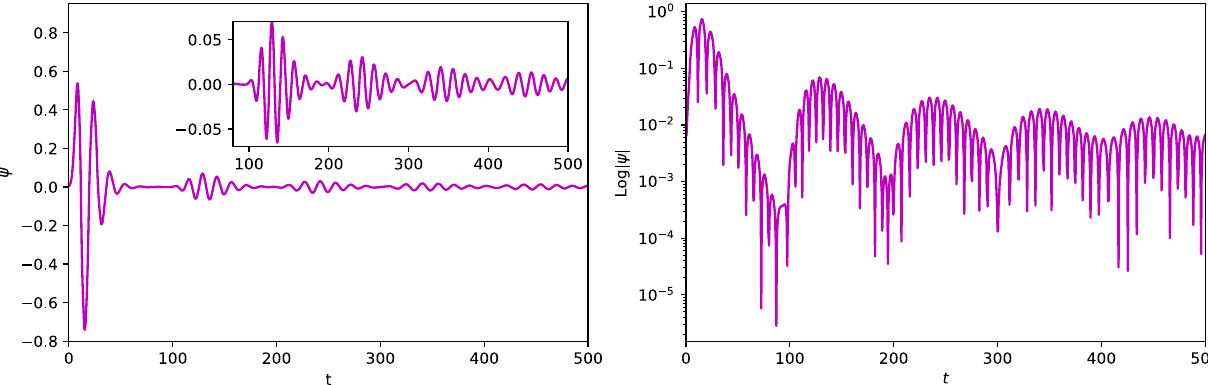
Fig. 9 The GWs echoes of electromagnetic field perturbation (left panel) and semilogarithmic plots for the GWs echoes of electromagnetic field (right panel) to black bounces in a cloud of strings with M = 0 . 5 , l = 1 , L = 0 . 1 , a = 1 . 12